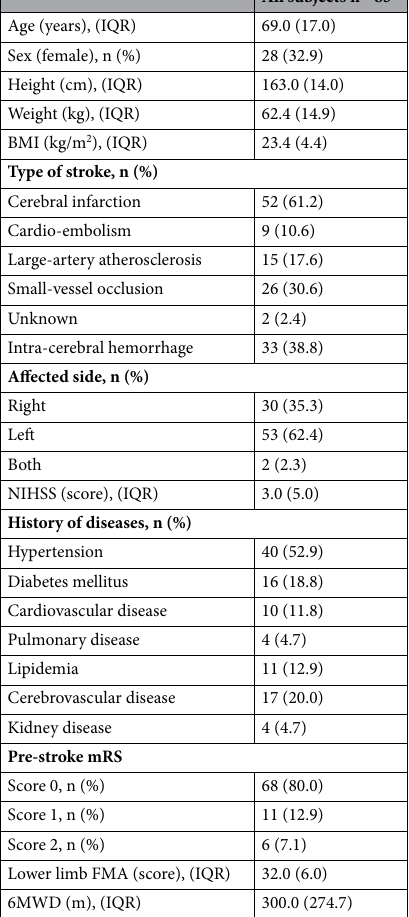
Table 1. Patient demographics and clinical characteristics. BMI, Body mass index; FAC, Functional ambulation category; FMA, Fugl-Meyer Assessment; IQR, inter quartile range.